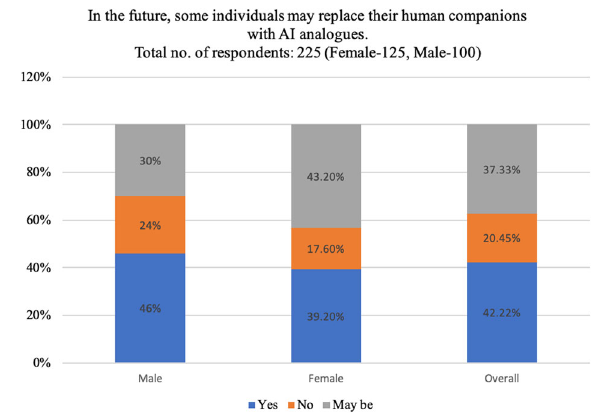
Fig. 6 In the future, some individuals may replace human companions with AI analogs. Total no. of respondents: 225 (Female: 125, Male: